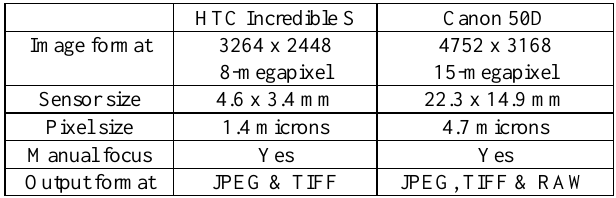
Table 1: Technical specifications of the